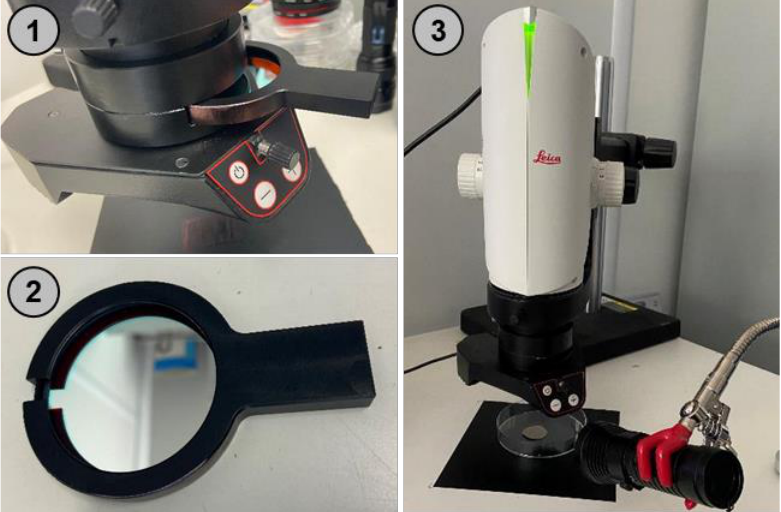
Figure 1. Modified digital microscope for fluorescent imaging. ( 1 ) Mounting bracket for emission filters. ( 2 ) Emission filter in holder. ( 3 ) Modified digital microscope with emission filter mounting bracket and LED flashlight. Table 2. List of flashlights used for fluorescence excitation.